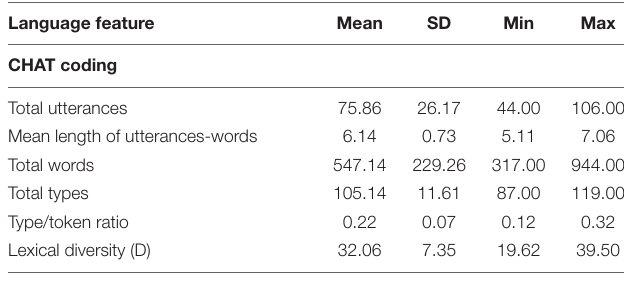
TABLE 3 | Descriptive statistics of linguistic complexity of teachers’ talk during book